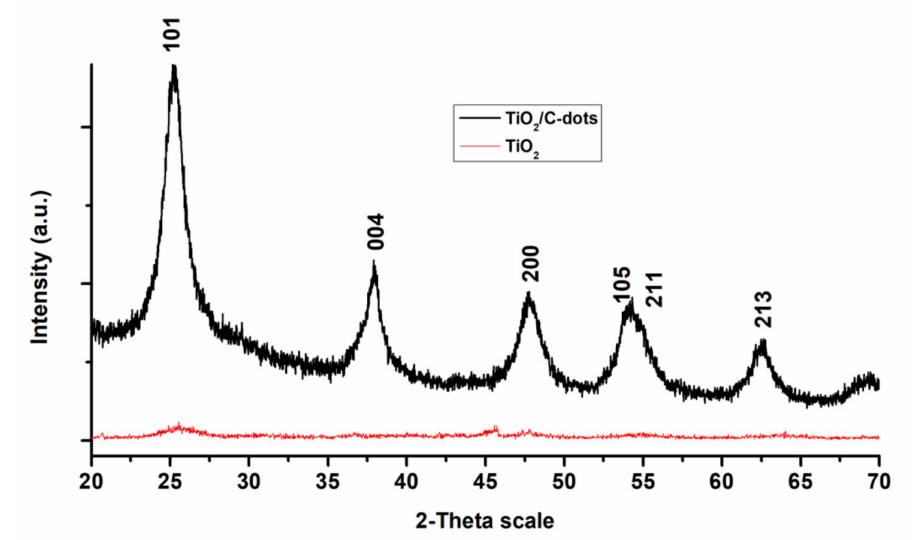
Figure 4. X-ray diffraction patters of TiO 2 and TiO 2 enriched with C-dots. The scanning electron micrographs of powdered TiO 2 /C-dots illustrated in Figure